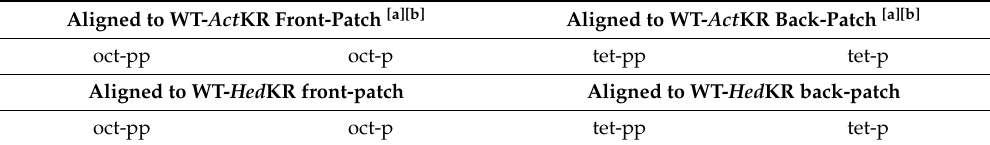
Table 2. MD Simulation Round 2, including 4 WT- Act KR-ligand complexes and 4 WT- Hed KR-ligand complexes prepared through structure alignment, using DM- Act KR-(m-oct-pp) and DM- Act KR-(m-tet-p) co-crystal structures as templates.